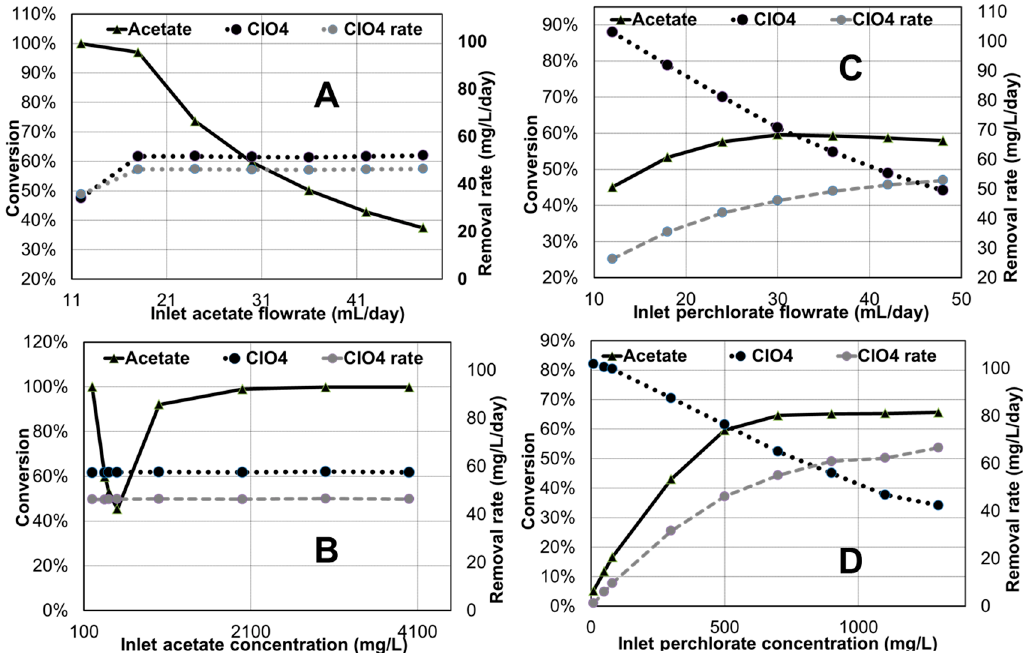
Figure 4. Influence of different variables on conversion for perchlorate remediation base case simulation (Anode: inlet flow rate − 300 mL/day, acetate concentration − 350 mg/L, volume − 200 mL; Cathode: inlet flow rate − 300 mL/day, perchlorate concentration − 350 mg/L, volume − 200 mL; proton exchange membrane used; external resistance is 419.01 ohms). ( A ) Effect of inlet acetate flow rate; ( B ) Effect of inlet perchlorate flowrate; ( C ) Effect of inlet acetate concentration; ( D ) Effect of inlet perchlorate concentration.